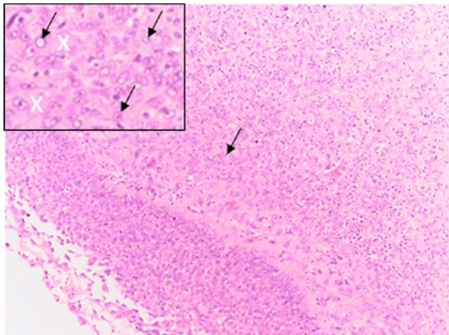
Figure 15. Histological image and zoom of the central region (square in the left corner) of a metaplastic carcinoma stained by H&E method. The white crosses indicate collagen, black arrows the